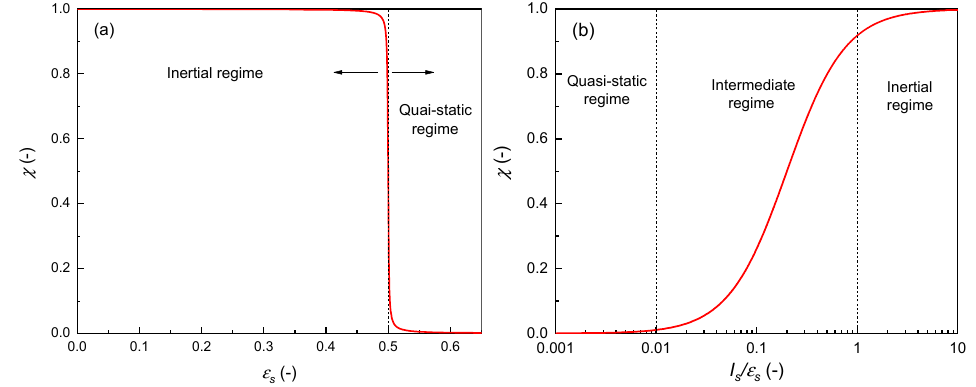
Figure 6. Blending function proposed by different authors, ( a ) Liu et al. [58] with ε s,min = 0.5 and ε s,max = 0.65, ( b ) Chialvo and Sundaresan [31].